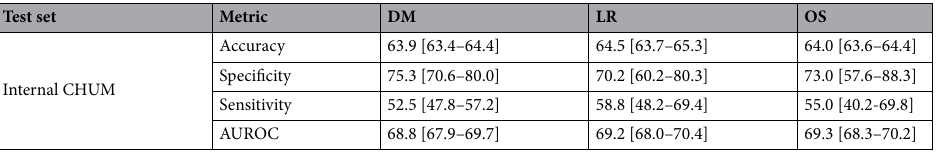
Table 3. Performance on the Internal CHUM dataset. Training is performed in the entirety of the TCIA dataset, with 298 samples. Testing is performed on the Internal CHUM dataset, with 371 samples. In both training and testing sets, the CHUM institution was seen by the model. Accuracy is normalized per class frequency.